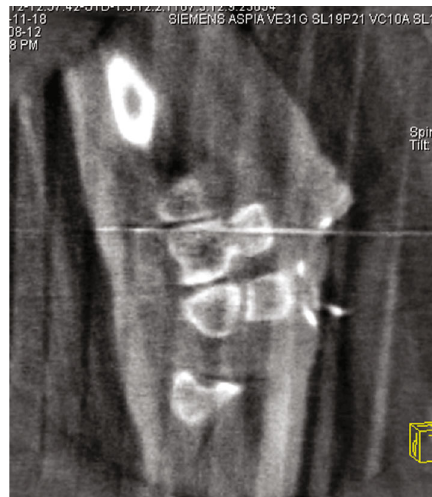
Figure 4: Intraoperative CT scan (sagittal view) showing the anatomical reduction of the hamate hook.